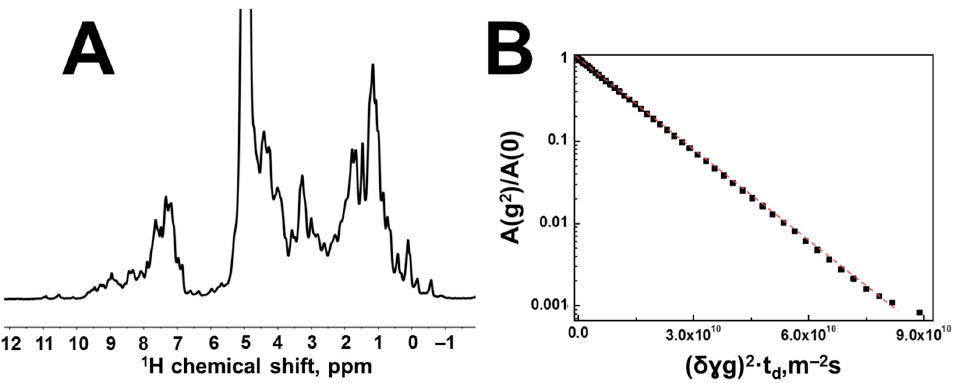
Figure 6. ( A ) Proton spectrum of an aqueous solution of hen egg-white lysozyme at a protein concentration of 4% (wt.). ( B ) Diffusion decays of aqueous solution of HEWL at a concentration of 4% (wt.). Diffusion decay was obtained by integrating the BSA signals located in the region of chemical shifts from 0 to 3 ppm. The solid line shows the SDC with the value 4.28 × 10 − 11 m 2 /s. This diffusion decay was recorded at a diffusion time of 50 ms and a temperature of 298 K.